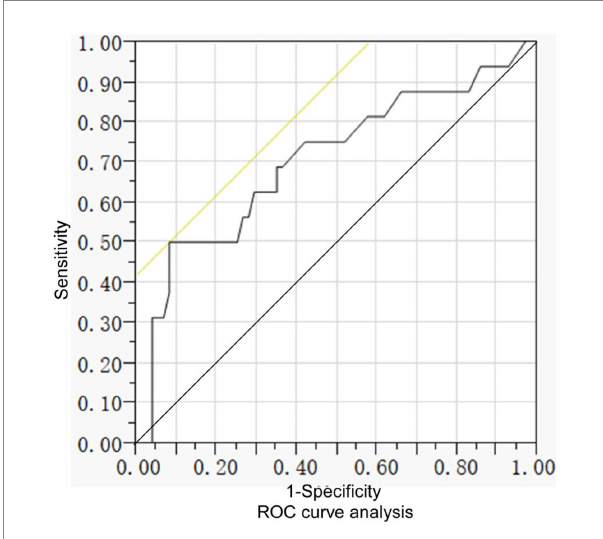
FIGURE 3 Receiver operating characteristic (ROC) curve analysis of the duration from symptom onset to recanalization as a risk factor for peri-procedural